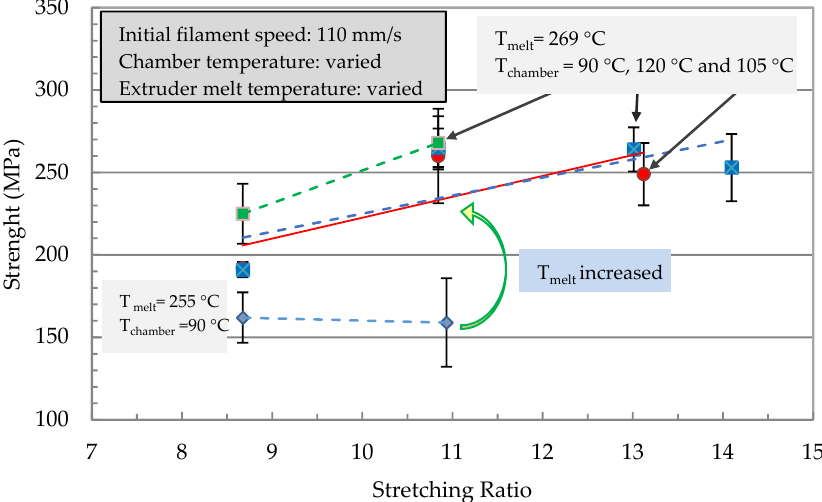
Figure 8. Tensile strength of the stretched PP with 22% PET filaments as a function of the stretching ratio for different processing temperatures of the extruder (melt temperature) and the stretching chamber.